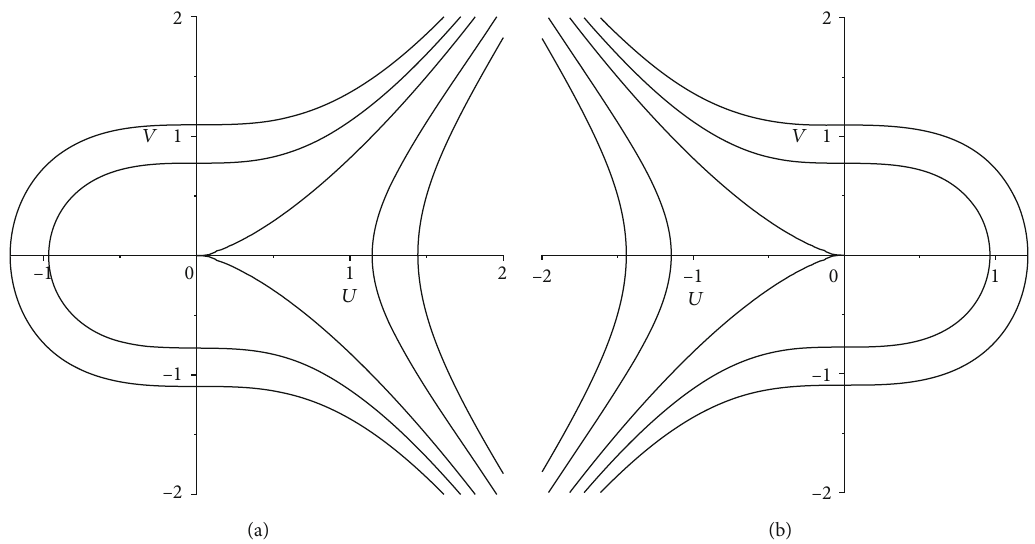
Figure 3: The phase portraits of the system (9) for B = 0 : (a) A > 0 ; (b) A < 0